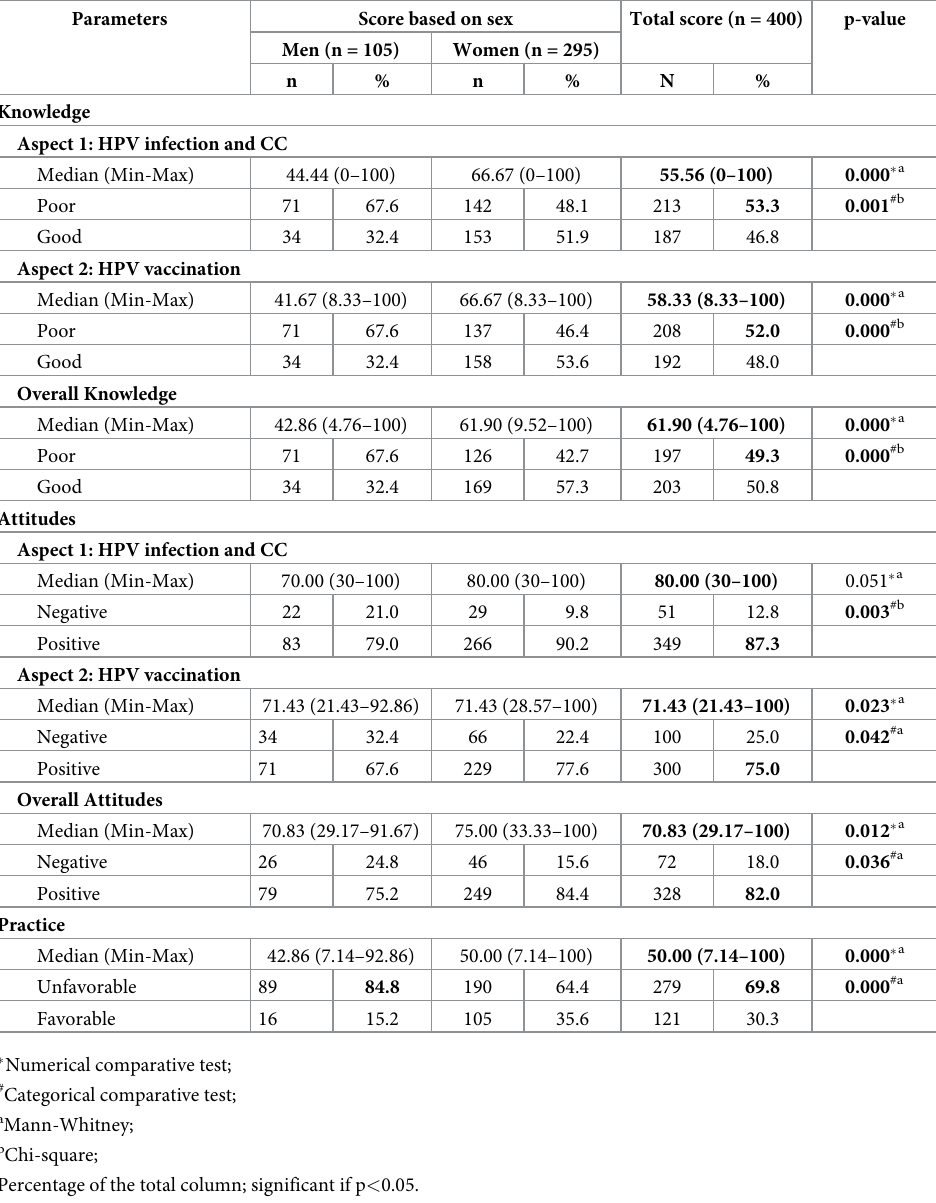
Table 2. Level of knowledge, attitudes, and practice aspects towards HPV, CC, and corresponding vaccine in an urban community Indonesia graded by sex.